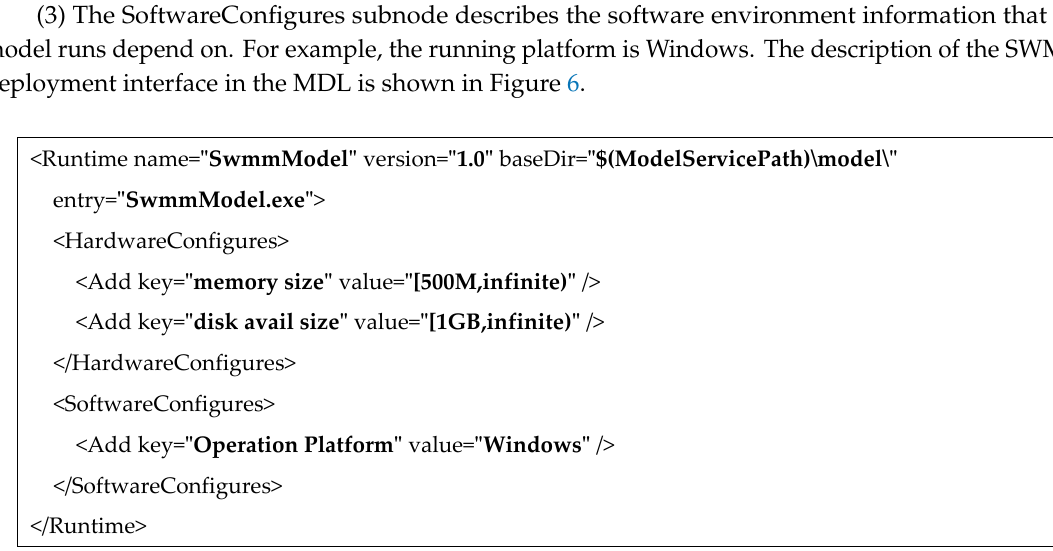
Figure 6. Description of the model deployment interface in the MDL.